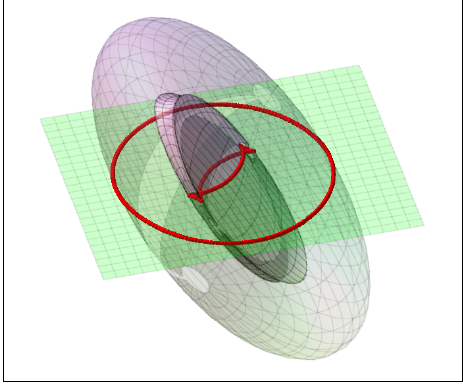
Figure 1. The section of an offset by a